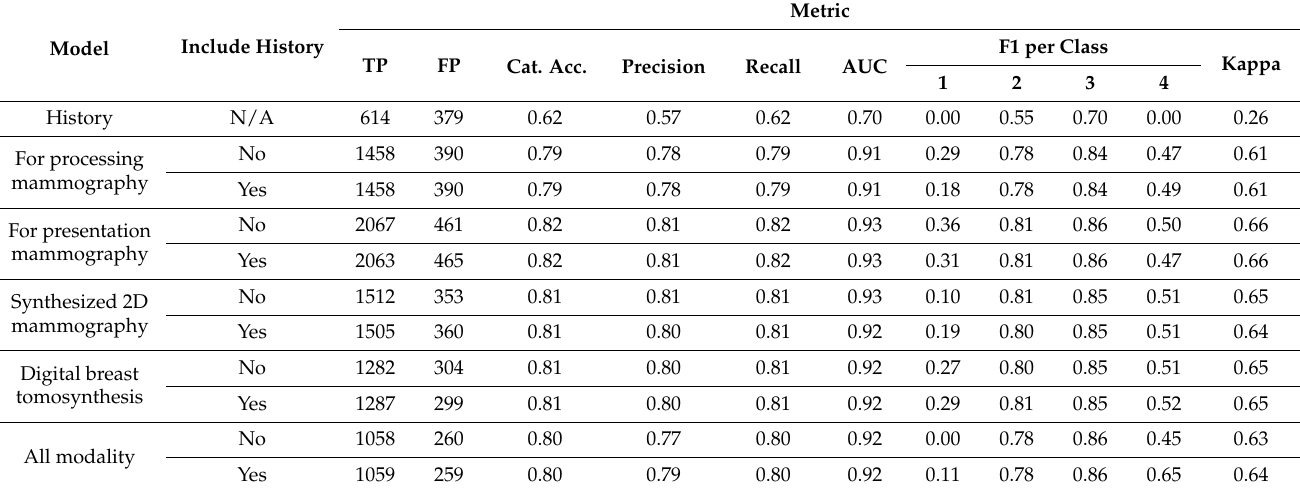
Table 1. Model accuracy on their respective test dataset for all screening years for 4 BI-RADS categories.